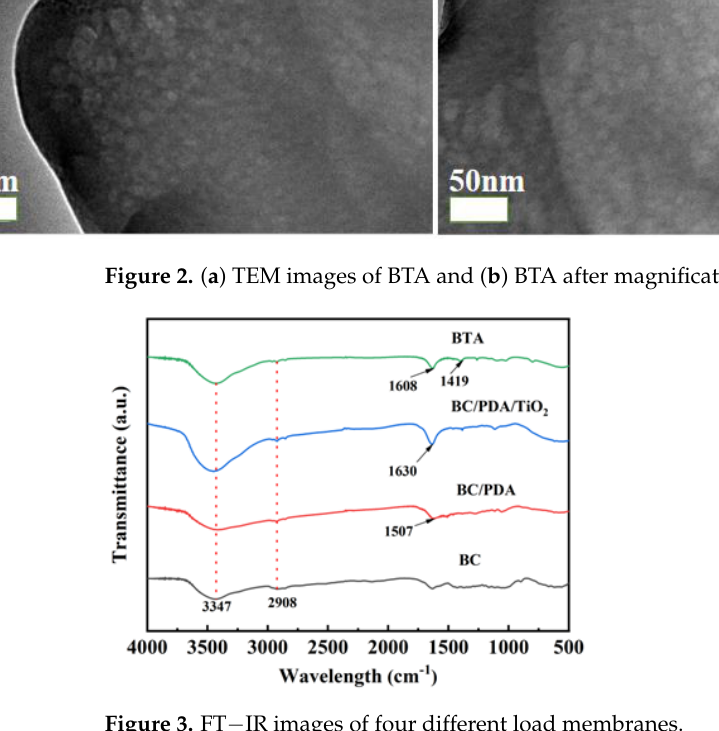
Figure 3. FT − IR images of four different load